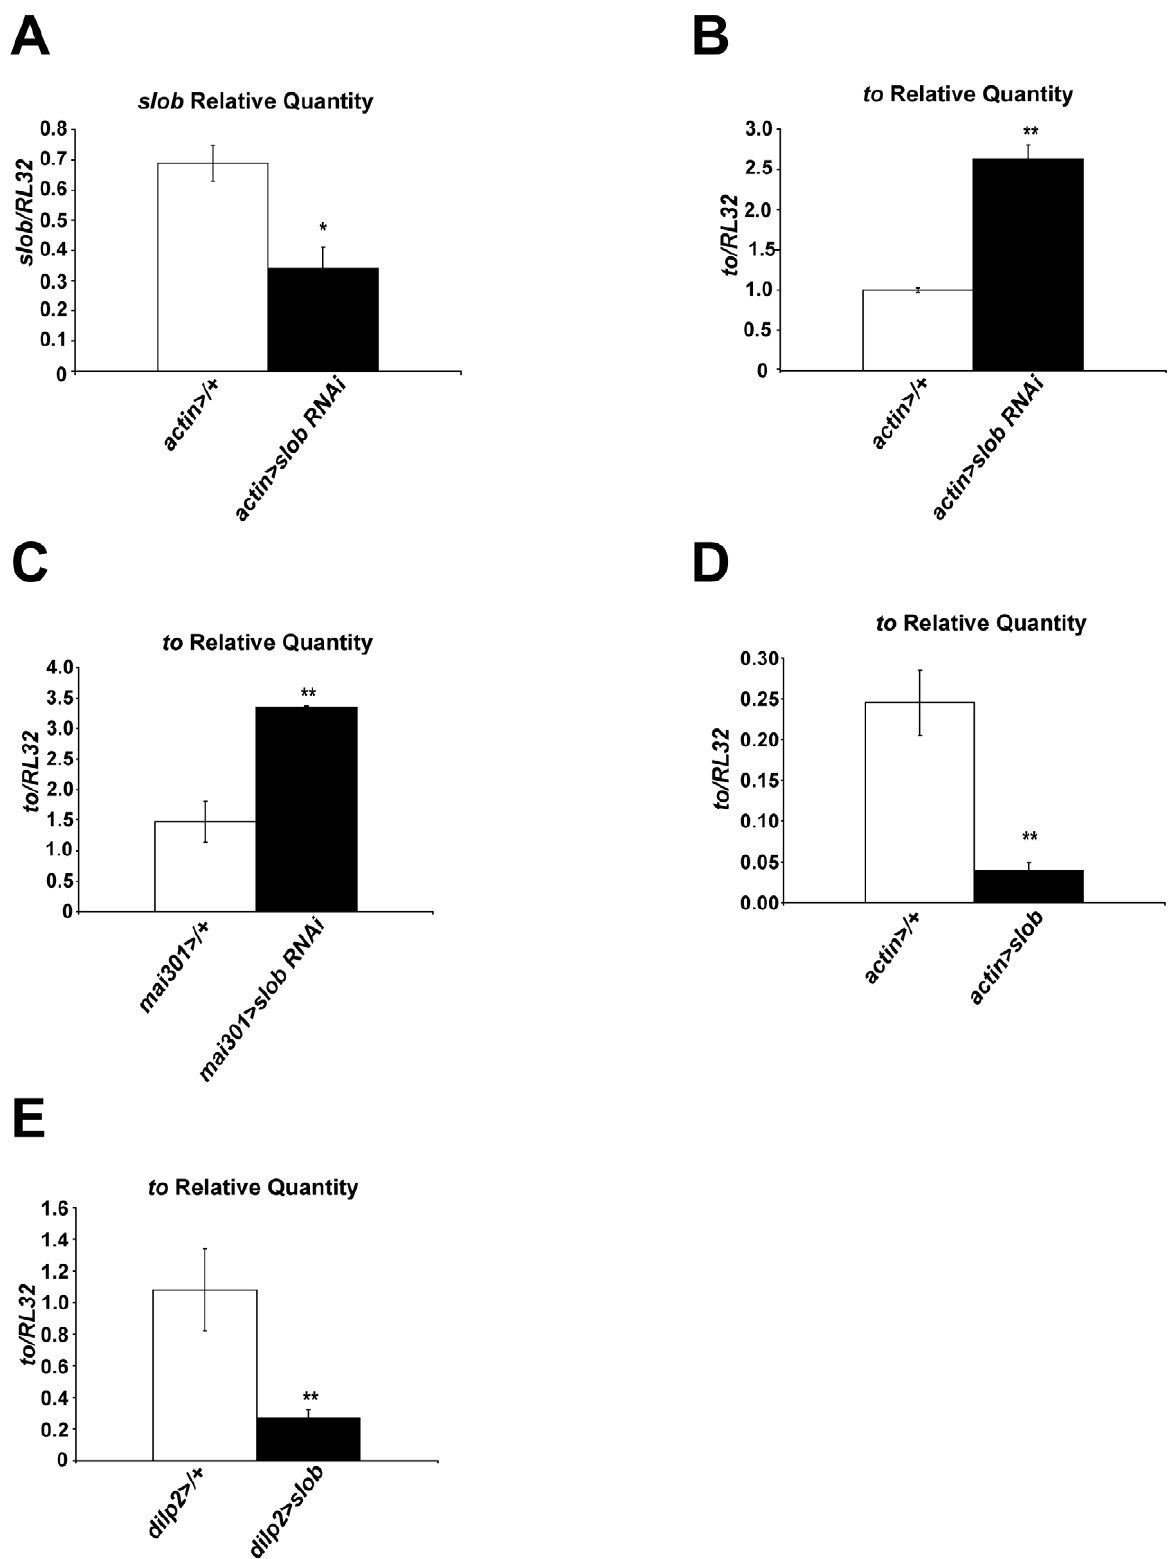
Figure 3. to mRNA levels are dependent on expression of SLOB. Slob and to levels in fly heads were measured by qPCR. A , Relative slob transcript levels are decreased in heads of flies in which SLOB expression was knocked down ubiquitously using RNAi. B , Relative to transcript levels are increased in heads of flies in which SLOB expression was knocked down ubiquitously using RNAi. C , Relative to transcript levels are increased in heads of flies in which SLOB expression was knocked down in mNSCs using RNAi. D , Relative to transcript levels are decreased in heads of flies in